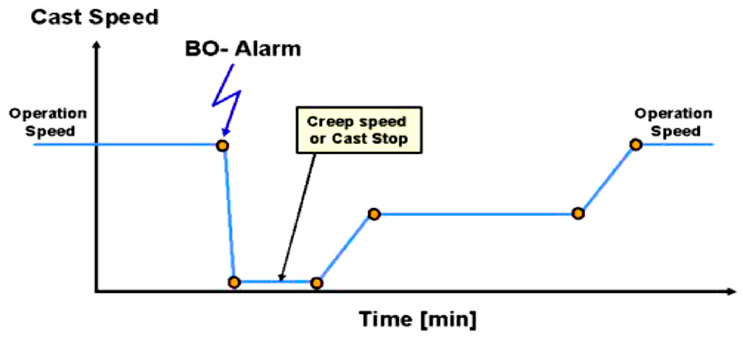
Figure 14. Breakout prevention. Table 8. Casing speed depends on the type of steel, tundish temperature, and size of cold slab width.